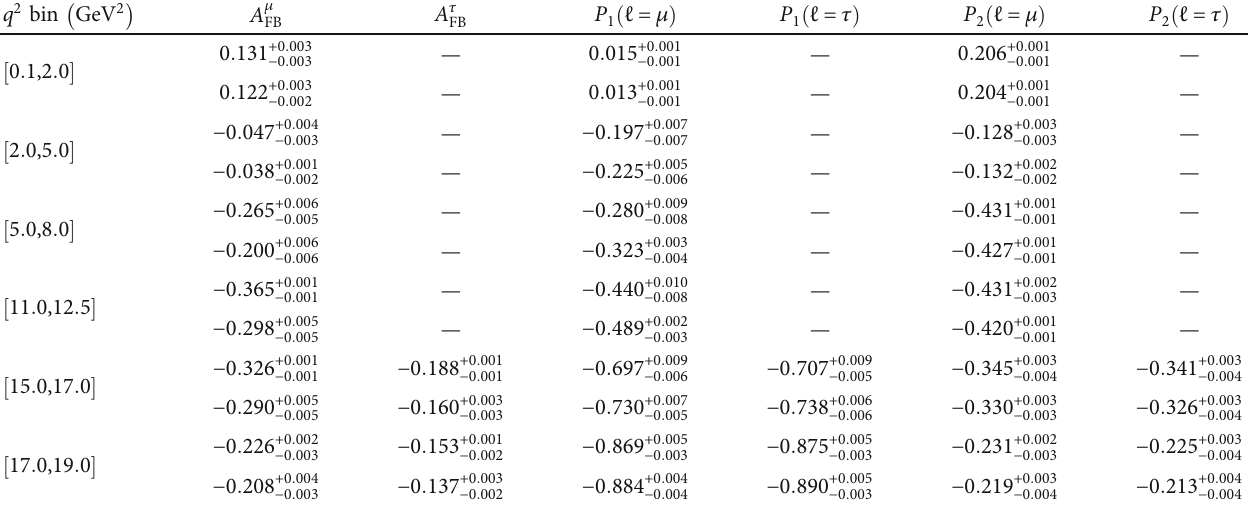
Table 11: Theoretical predictions for the q 2 -binned observables A μ fi rst low) and “ PQCD+Lattice ” (the second row)